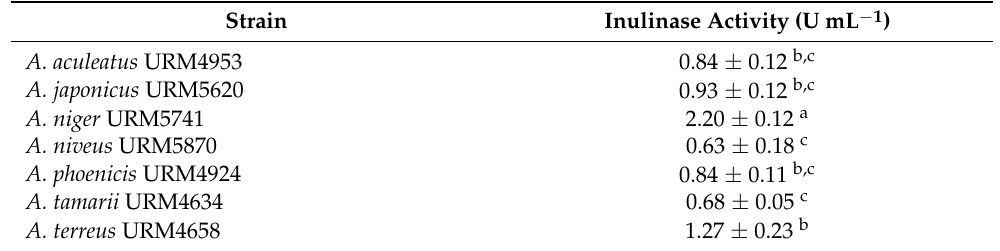
Table 1. Inulinase activity of crude extracts obtained by submerged fermentation using different Aspergillus strains and inulin from chicory as a